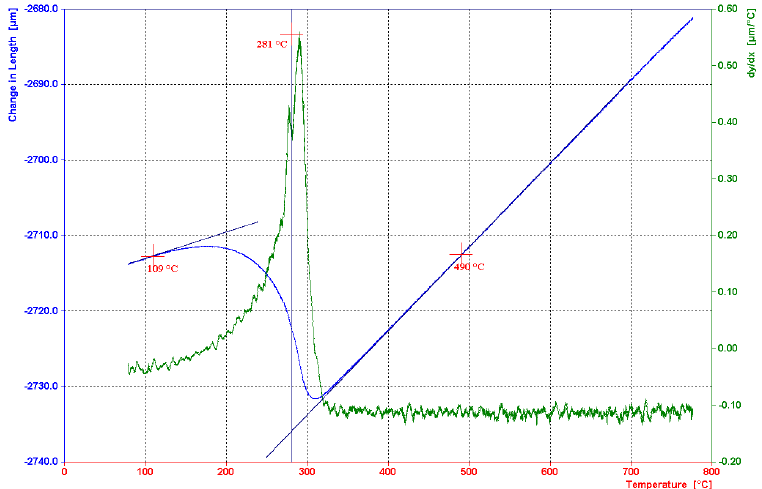
Figure 10. Dilatometric curve registered during cooling of 5 Mn steel at a rate of 1 °C/s.